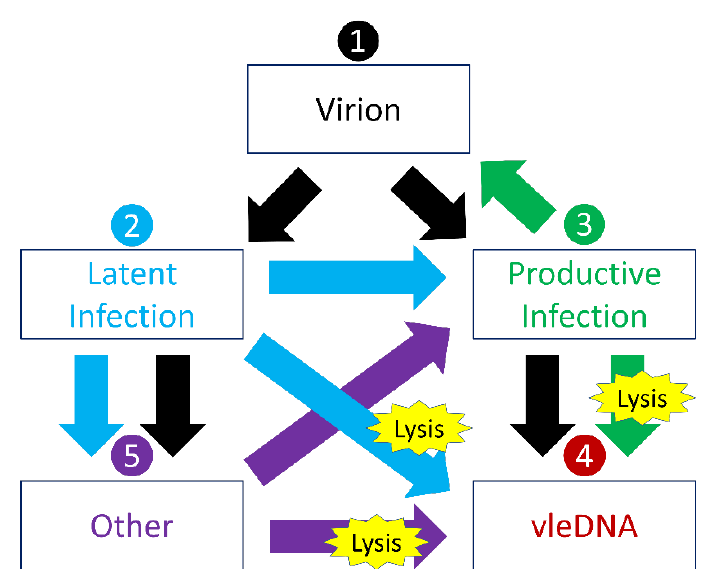
Figure 1. Di ff erent categories of sources of environmental viral genomic DNA. Free virions ( 1 ) initiate latent infections via cell adsorption ( 2 ) or instead initiate productive infections ( 3 ), where the latter can be di ff erentiated into lytic vs. chronically releasing virions (not distinguished in the figure). Virus-like eDNA (vleDNA) is a form of extracellular, unencapsidated DNA ( 4 ). Viral infections also can take on various forms described here as ‘Other’ ( 5 ).